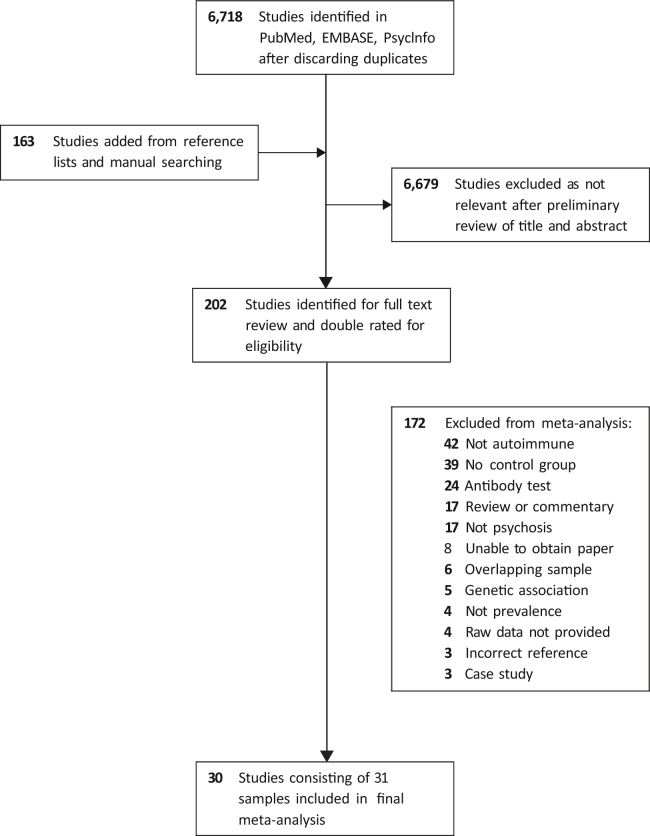
Search process. Overview of the review process and reasons for exclusion.